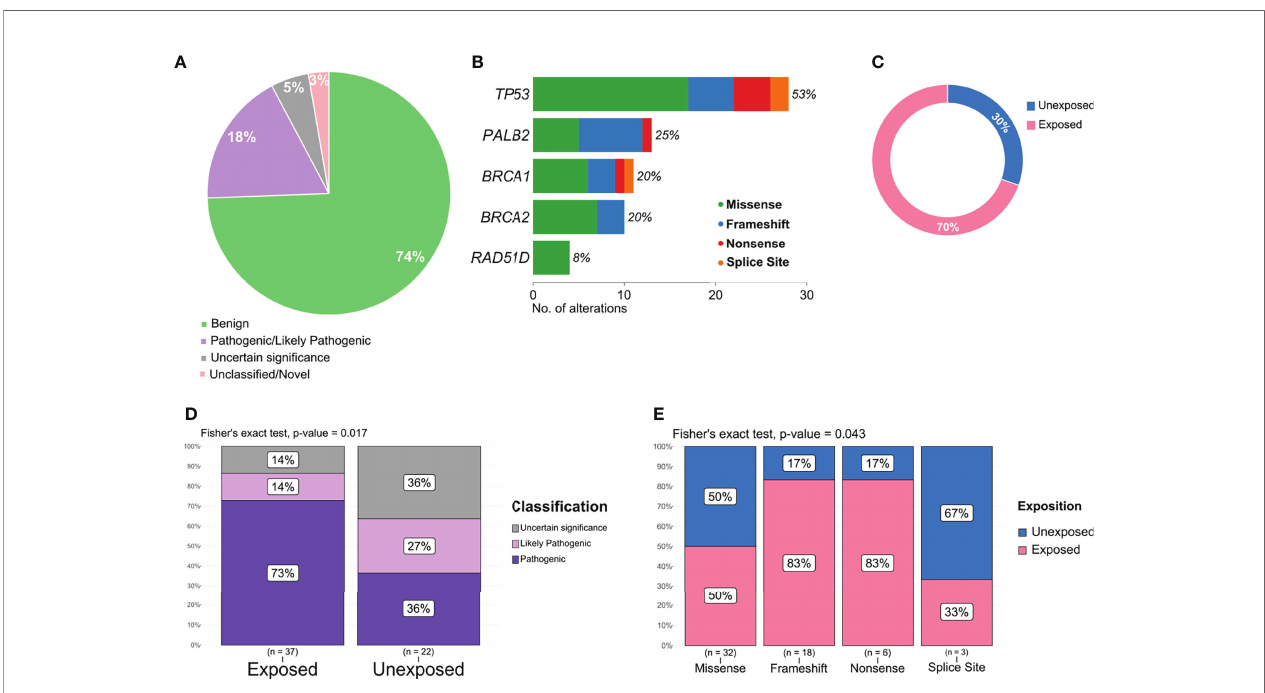
FIGURE 4 | Distribution and frequency of pathogenic, likely pathogenic, and variant of uncertain signi fi cance (VUS) variants. (A) Graphical representation of variant classi fi cation detected in all samples. (B) Frequency and type of pathogenic, likely pathogenic, and VUS variant identi fi ed in each gene. (C) Proportion of pathogenic and likely pathogenic variants detected according to patient exposure status. (D) Frequency of variants classi fi ed as pathogenic, likely pathogenic, or VUS in exposed and unexposed groups. (E) Frequency of variants classi fi ed as missense, frameshift, nonsense, and splice site according to exposed and unexposed